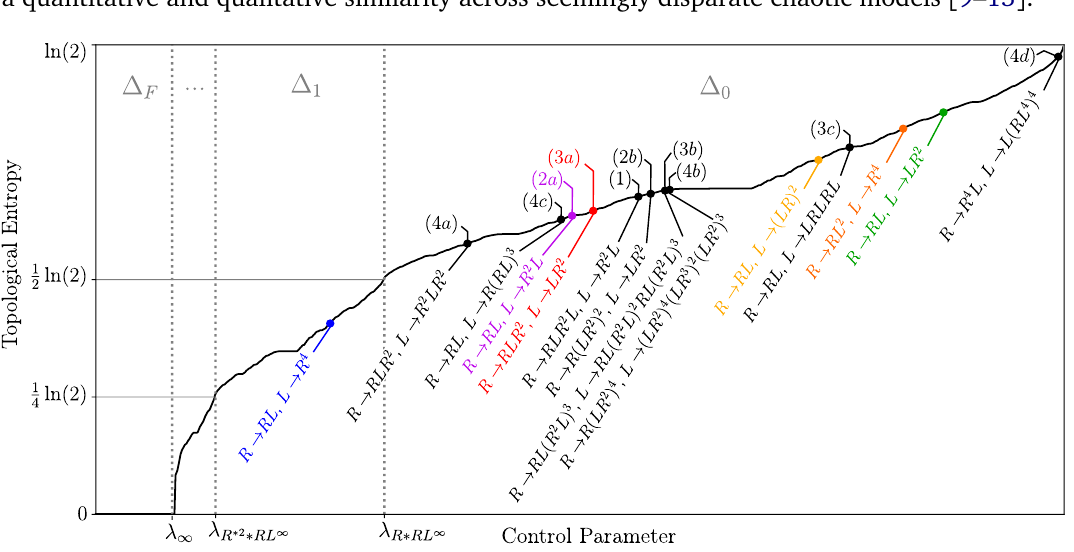
Figure 1: The topological entropy as a function of control parameter λ in the Lo- gistic map (Eq. (1)). The characteristic multifractal shape is known as a Devil’s Staircase [ 1 ] . The plot was generated by finding the smallest positive zeros of the truncated kneading determinants numerically for itineraries of f λ ( x ) = 1 − λ x 2 cor- responding to λ ∈ [ 1.35,2.00 ] , uniformly sampled (see Section 4). The point λ ∞ corresponds to the infinite word R ∗∞ (notation defined in Section 4.3). The point λ marks the lower bound of the interval ∆ , and the upper bound of the in- R ∗ RL ∞ 0 terval ∆ . The point λ marks the lower bound of the interval ∆ and the R ∗ 2 ∗ RL ∞ 1 1 upper bound of the interval ∆ . The accumulation points of several substitution se- 2 quences are indicated, with the substitutions listed below the curve. Where colours are used, they are consistent between figures. In the cases that accumulation points correspond to generalised time quasilattices, the Boyle-Steinhardt class is indicated above the curve (see Section 3) [ 2 ]